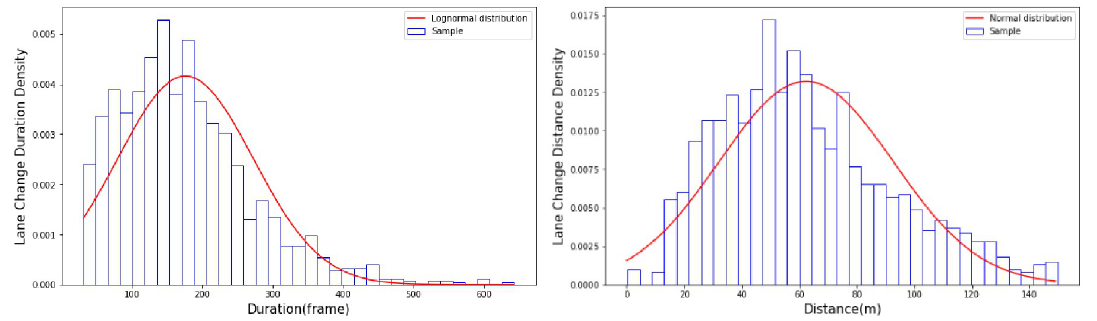
Fig 6. Statistical histogram of the lane-changing duration and